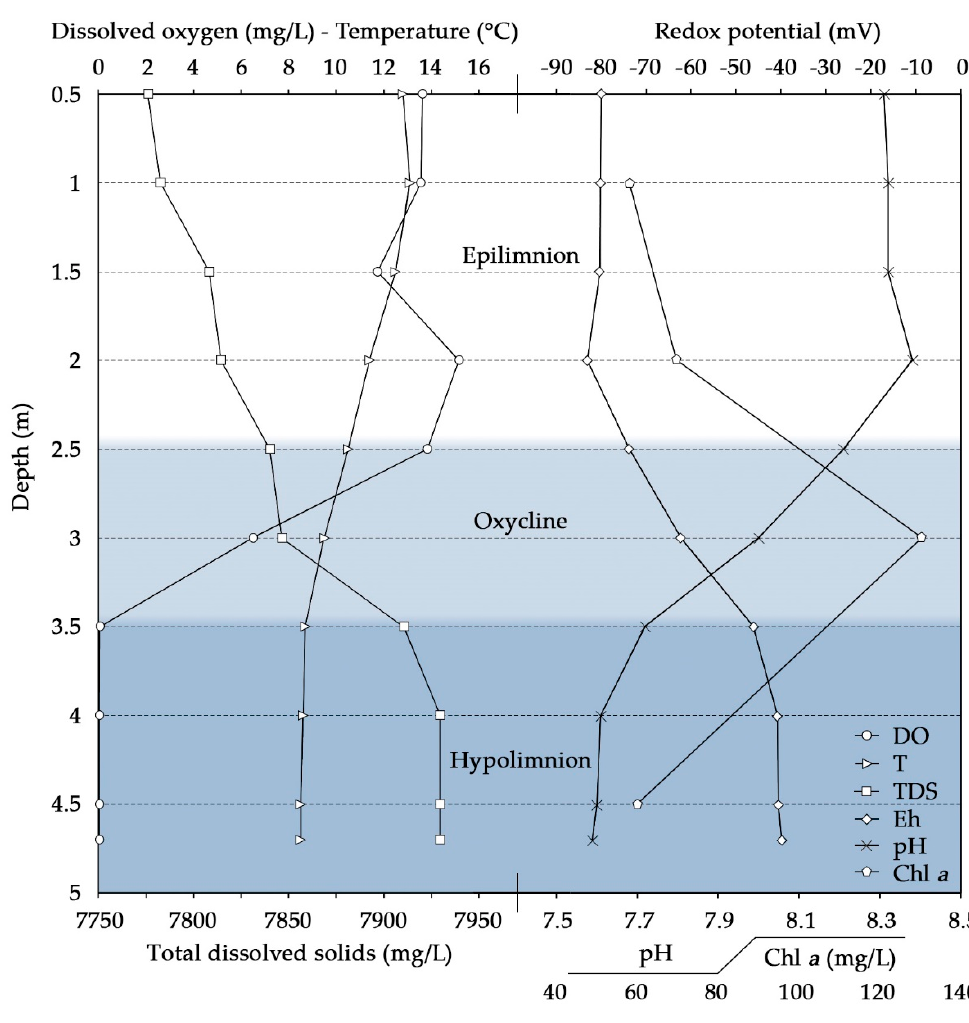
Figure 1. Physico-chemical properties of water column from Lake Alboraj were recorded during the spring oxycline state (13 March